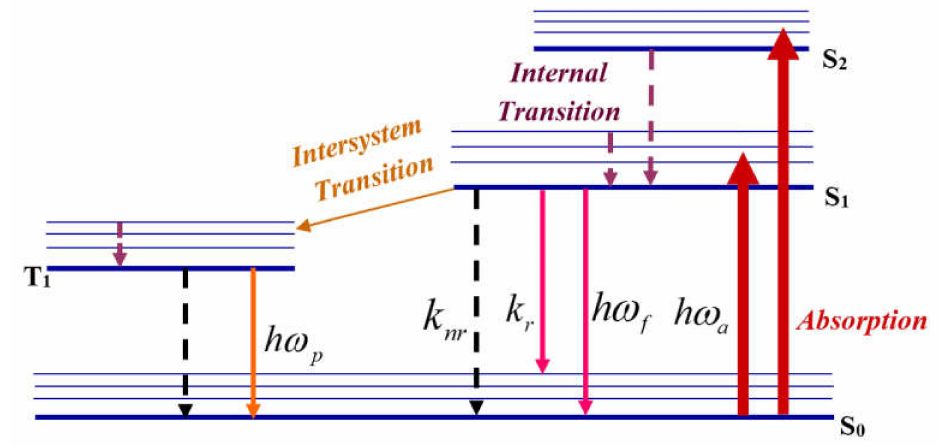
Figure 1. Jablonski diagram showing the processes of fluorescence and